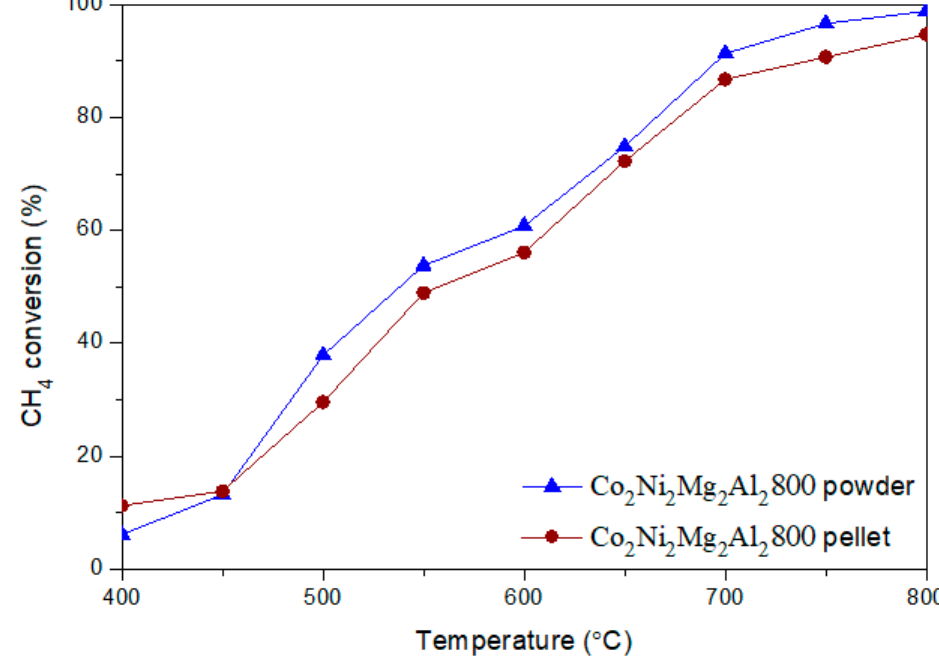
Figure 5. Evolution of the conversion of methane in DRM versus reaction temperature for the two different forms (powder and pellet) of Co 2 Ni 2 Mg 2 Al 2 800.